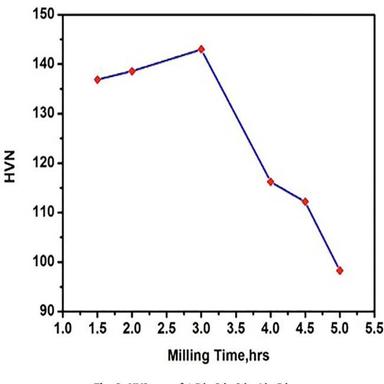
HV3 test of 1.5 h, 2 h, 3 h, 4 h, 5 h.